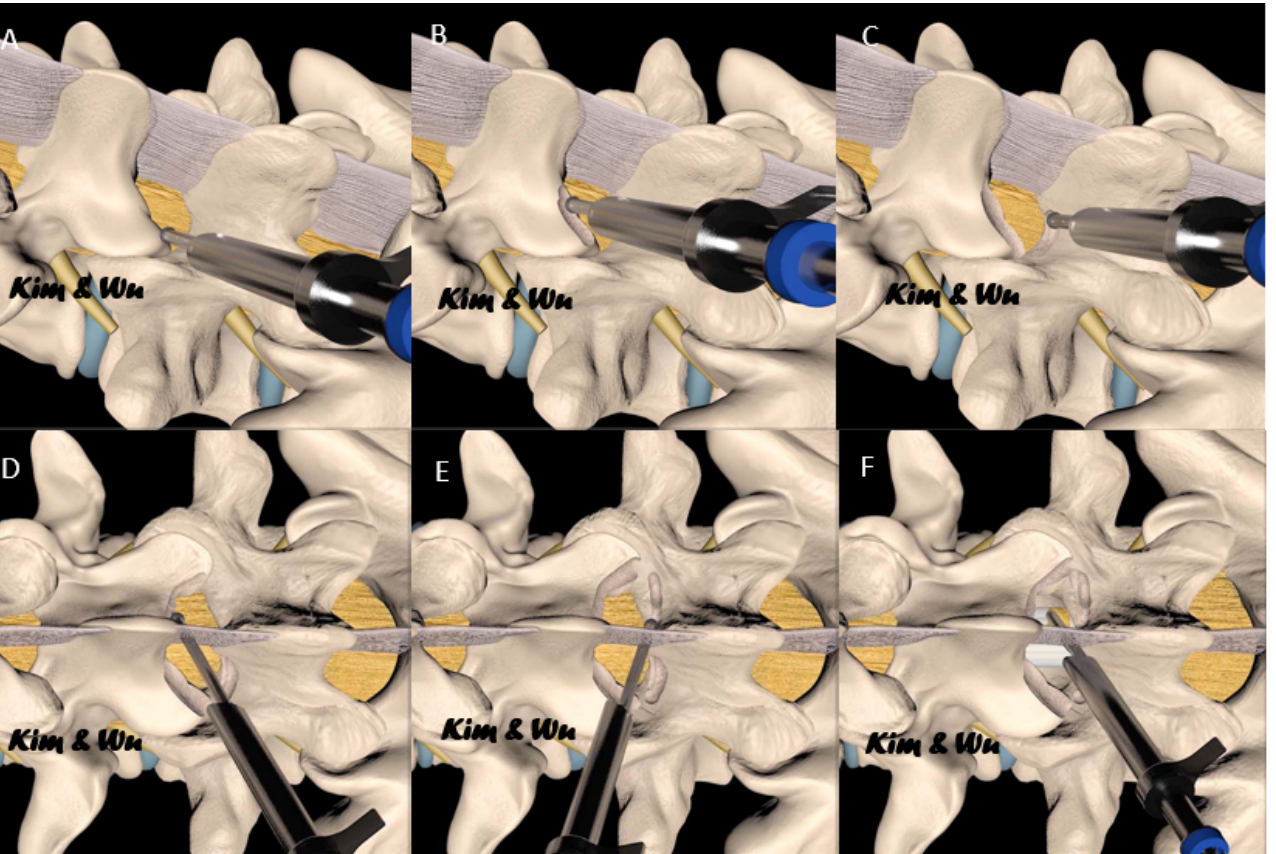
Figure 2. Graphical sketch of the steps of lumbar endoscopic unilateral laminotomy with bilateral decompression (LE-ULBD). ( A ) endoscopic decompression of the ipsilateral facet joint. ( B ) decompression continues to the ipsilateral lamina, ( C ) ipsilateral caudal lamina decompression is performed. ( D ) After decompression of base of the spinous process of the cephalad lamina, the contralateral decompression of the cephalad lamina is performed over the top of the ligamentum flavum ( E ) after decompression of the base of the spinous process of the caudal lamina, the contralateral decompression of the caudal lamina is performed over the top of the ligamentum flavum. ( F ) Ligamentum flavum removed after completion of endoscopic decompression.